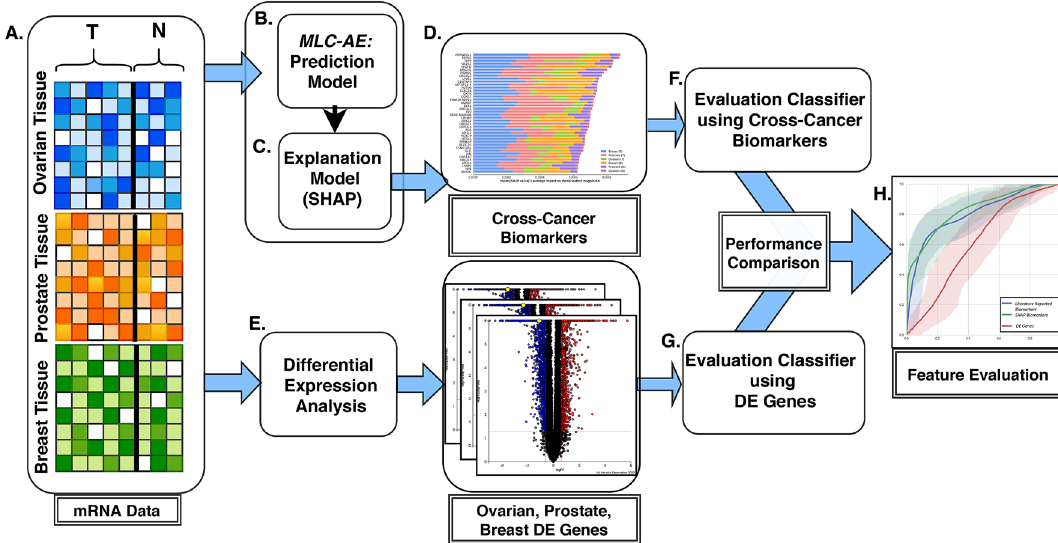
Figure 1. The proposed framework: ( A ) gene expression data from ovarian, prostate and breast tissues ( T : tumor, N : normal). ( B ) A multi-label classification auto-encoder (MLC-AE) is built to predict the tissue type (ovary, prostate and breast) and disease state (tumor and normal) of a given gene expression profile. ( C ) An explanation model (SHAP) is used to identify the contribution of each input node (gene) towards prediction. ( D ) The SHAP values are used to rank the genes. ( E ) In parallel, a differential expression analysis is used to identify the DE genes associated with ovarian, prostate and breast cancers. An evaluation classifier is built using only cross-cancer biomarkers of prostate cancer ( F ), and using only a randomly selected subset of DE genes ( G ). Finally, the performances of the evaluation classifier using the cross-cancer biomarkers and random set of DE genes are compared ( H